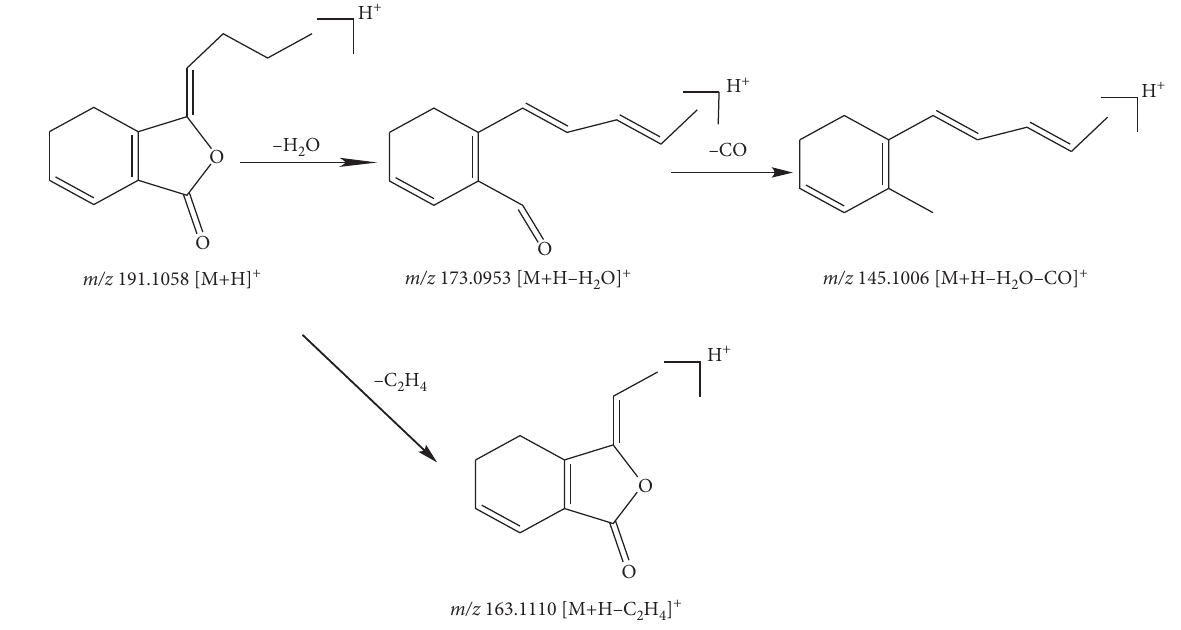
Figure 8: Possible fragmentation pathway of compound 33.